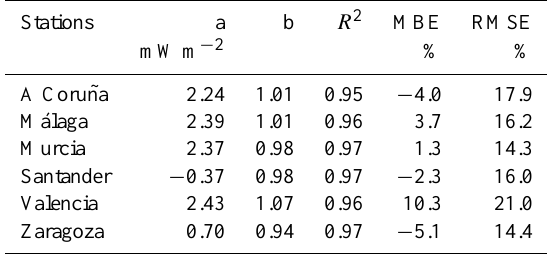
Table 4. Model results at each location. Table 5. Fitting parameters for Eq. (3) for different intervals of solar zenith angles.